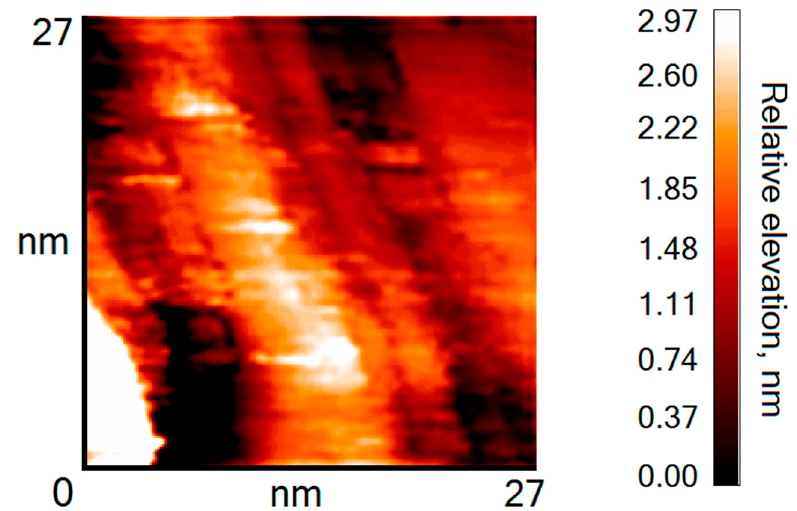
Figure 2. Surface topography of the titanium coating sample after oxidation in air ( t = 720 h, T = 300 K).